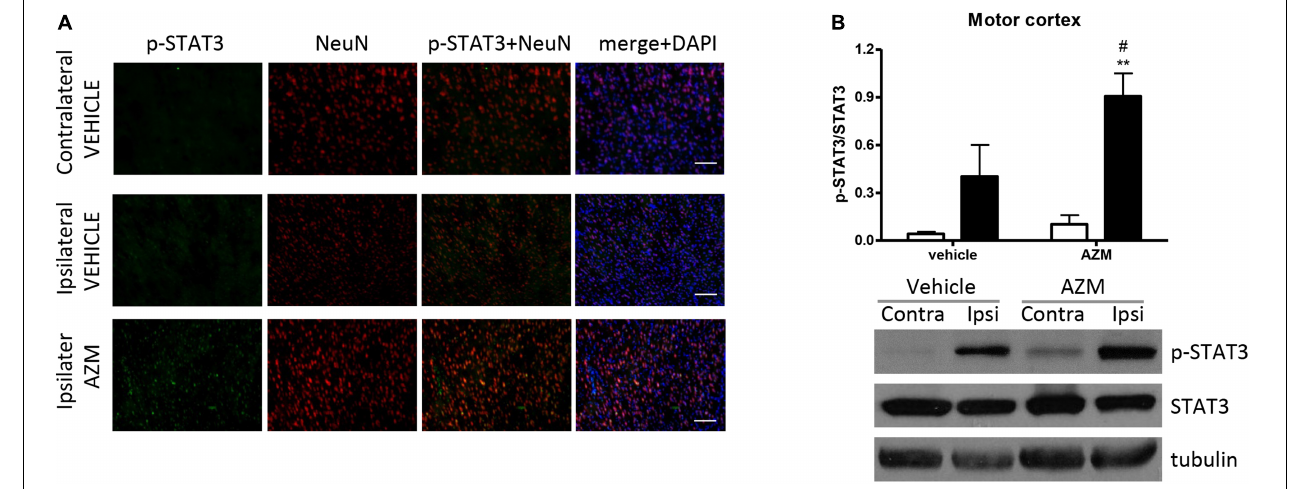
FIGURE 4 | Azithromycin elevates STAT3 phosphorylation in the motor cortex of rats subjected to 2 h MCAo followed by 22 h of reperfusion. (A) Representative immunofluorescence images of the contralateral and ipsilateral (ischemic) motor cortex of rats subjected to transient MCAo showing expression of p-STAT3 mainly in NeuN-positive neurons. Scale bars = 70 µ m. (B) Western blot analysis of phospho-STAT3 (Tyr705) (p-STAT3), total STAT3, and tubulin performed on brain homogenates from the ipsilateral (Ipsi, dark bars) and contralateral (Contra, white bars) motor cortex. Rats were treated with vehicle (0.9% NaCl) or azithromycin (AZM, 150 mg/kg), i.p., upon reperfusion. Data from the densitometric analysis of the autoradiographic bands are expressed as mean ± SEM of four independent experiments ( n = 4 rats per experimental group); ∗∗ P < 0.01 vs. AZM contralateral and # P < 0.05 vs. vehicle ipsilateral (two-way ANOVA for repeated measures followed by Bonferroni